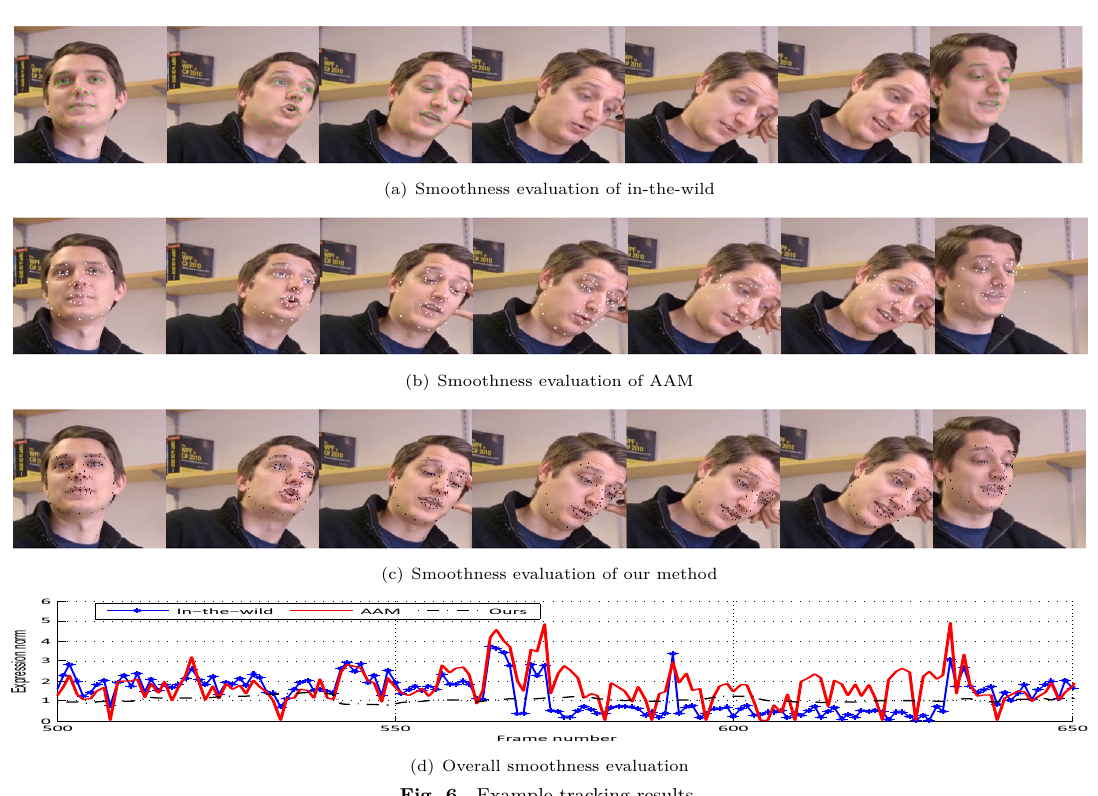
Fig. 6 Example tracking